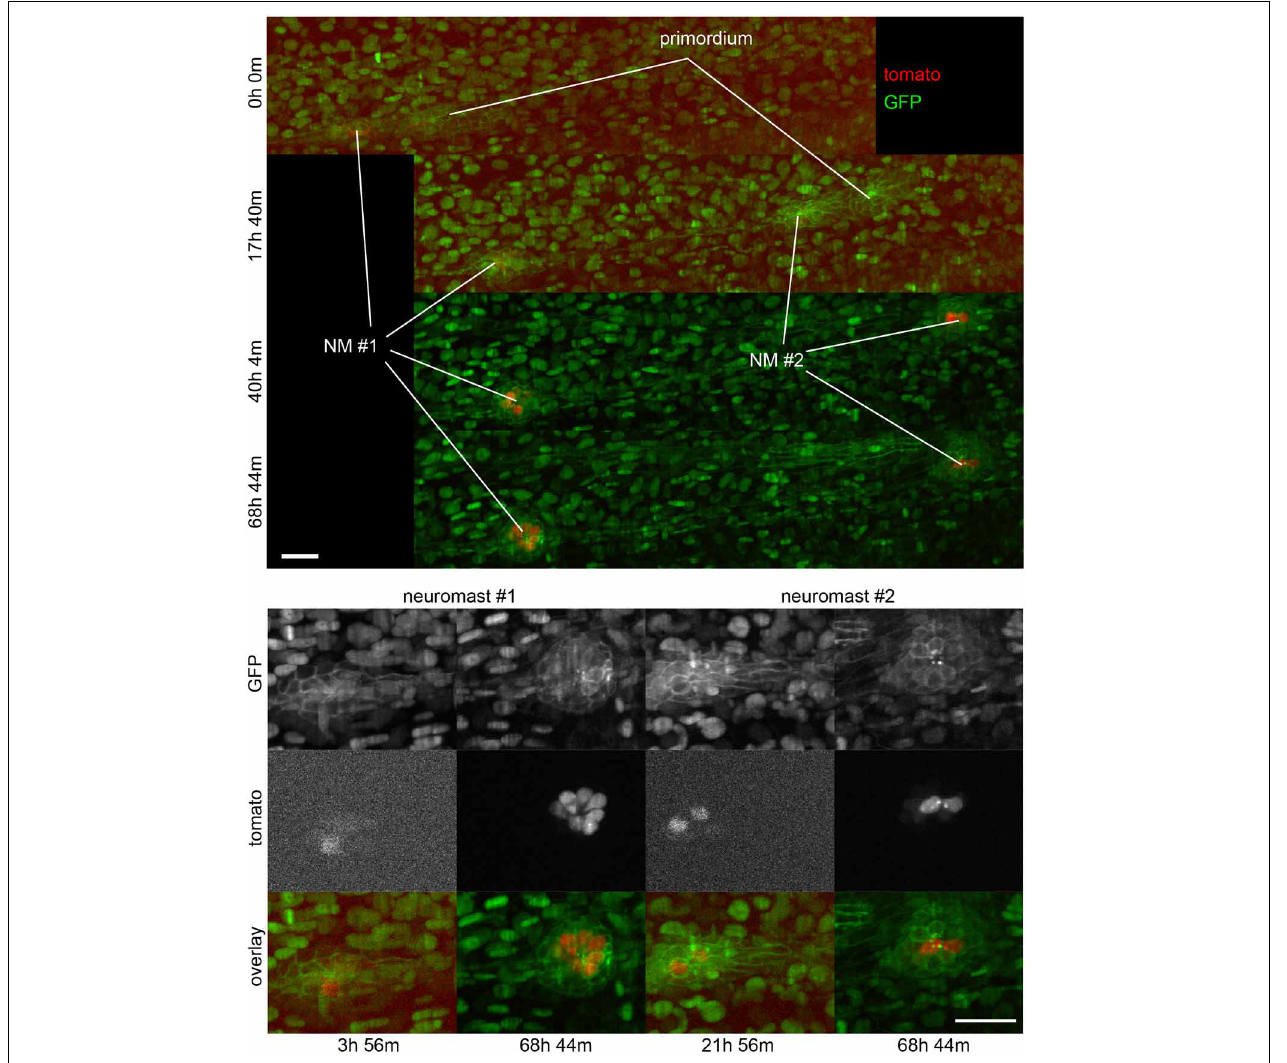
FIGURE 6 | Three-dimensional imaging by SPIM. Frames from Supplementary Movie 2 at the time-points indicated. Top , full field of view. Bottom , selected regions of interest containing neuromasts 1 and 2. A 2-channel 68h time-lapse recorded using SPIM, showing the deposition of 2 neuromasts and their subsequent development. Ath1 (showed in red) is expressed in hair-cells and can be detected in hair-cell progenitors a few hours before the neuromasts are deposited.